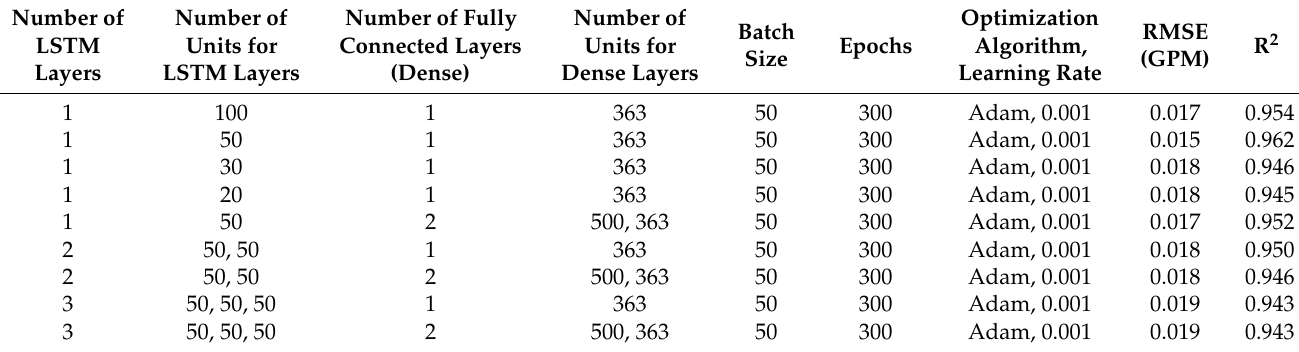
Table 3. Experimented LSTM models with selected